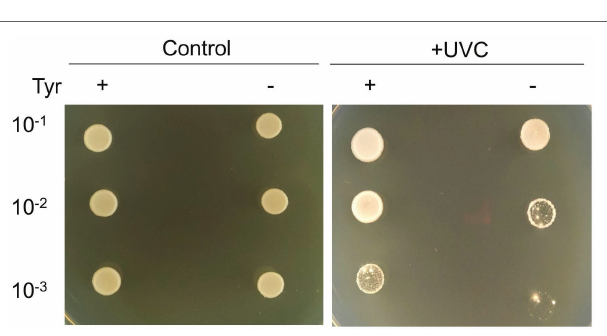
FIGURE 6 | Photoprotective properties of strain GR-TSA-9 T . Non-melanized and melanized GR-TSA-9 T cells were irradiated with 450 mJ/cm 2 UVC and then spotted in serial dilutions on TSA media for 3